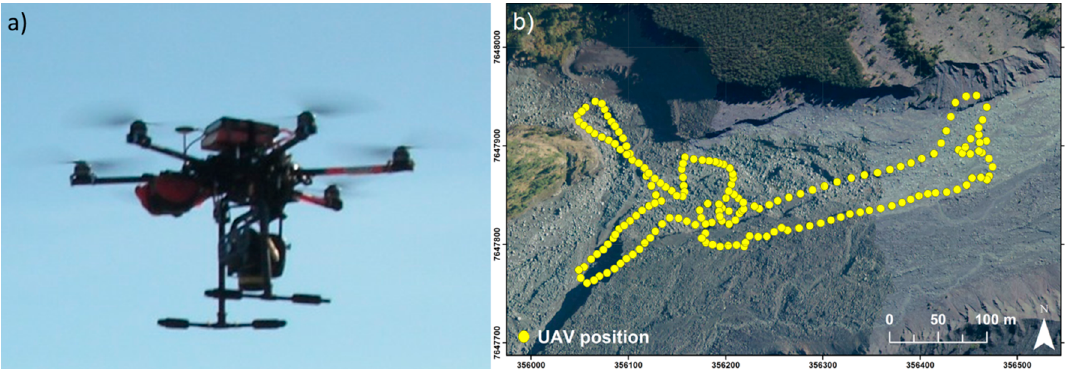
Figure 2. ( a ) DRELIO 10, Unmanned Aerial Vehicle (UAV) designed from an hexacopter platform 80 cm in diameter; ( b ) Flight plan performed on the study area of Mahavel landslide (background is an extract from the BD Ortho ® —orthorectified images database of the Institut Géographique National (IGN © ), 2008).